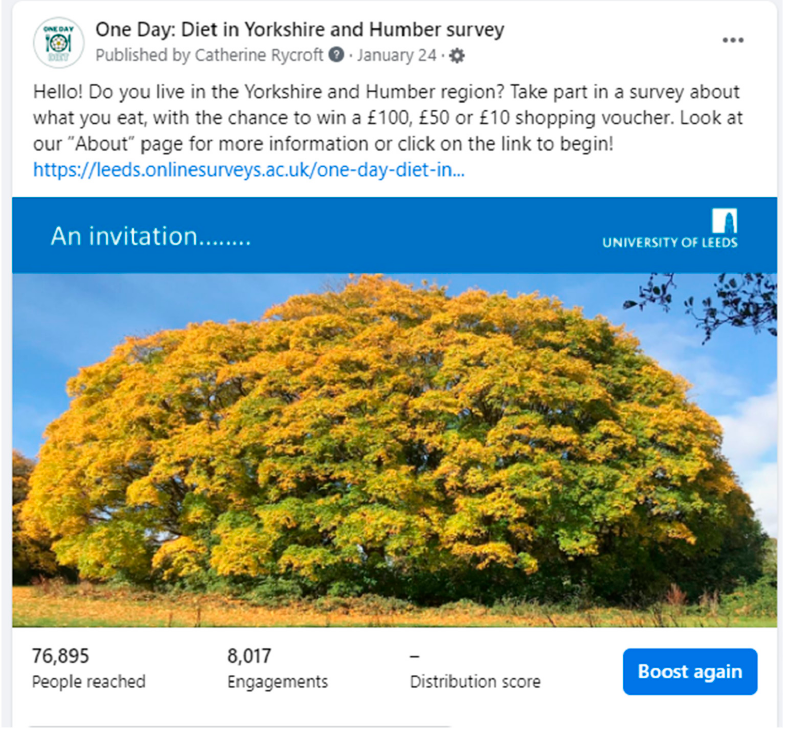
Figure A1. Example of study Facebook page.